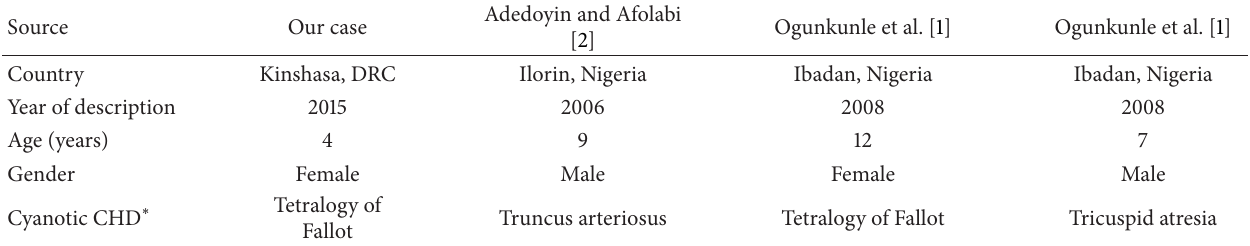
Table 1: Results of the literature review of cyanotic CHD associated with nephrotic syndrome in African children.